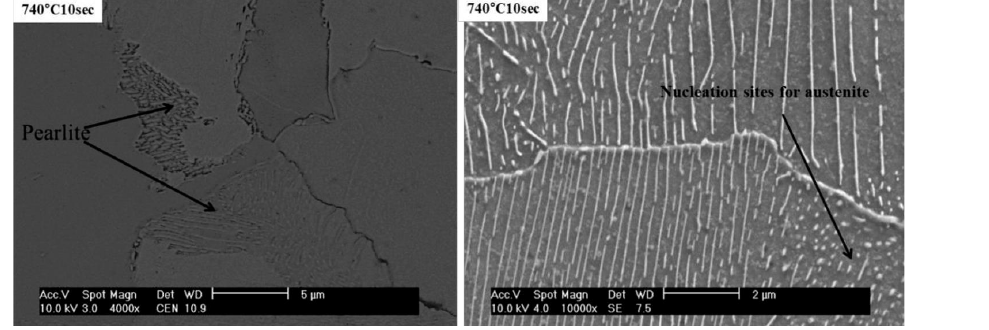
FIG. 3. SEM MICROGRAPHS OF RAPIDLY HEATED IN LEAD BATH FURNACE AT 740°C FOR 10